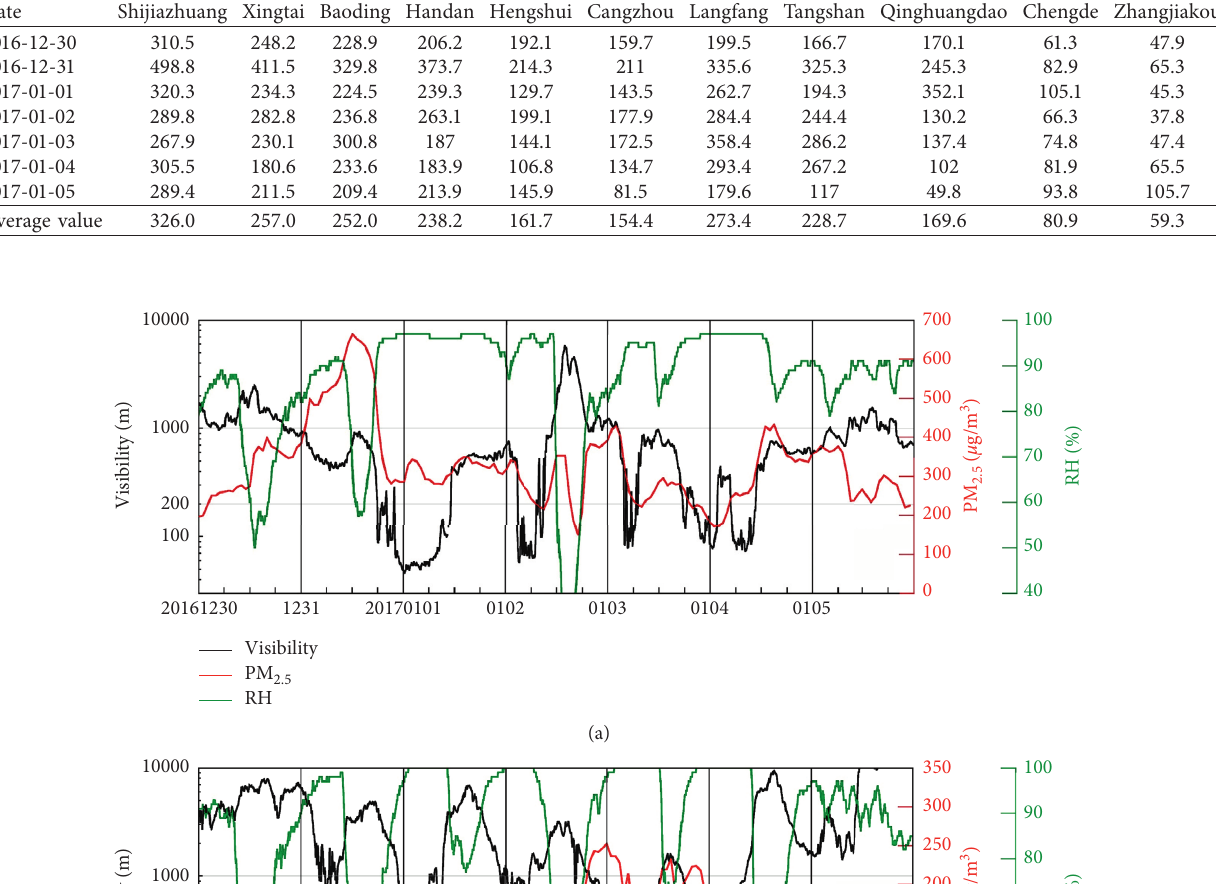
2.5 in cities of Hebei province from December 30, 2016, to January 5, 2017 ( μ g/m